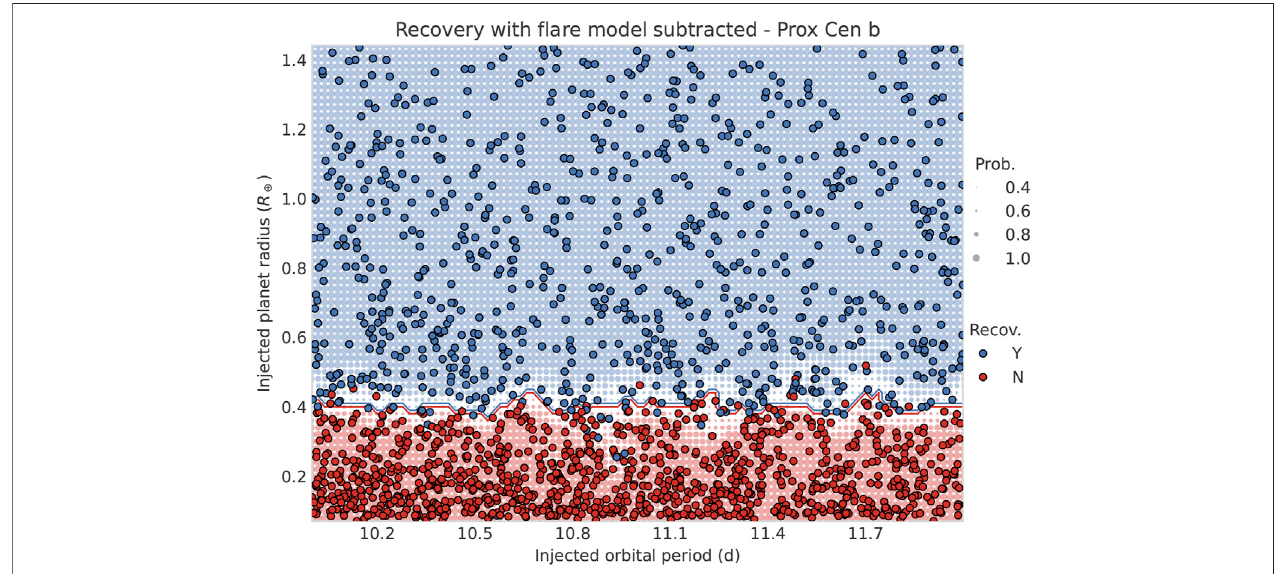
FIGURE3| Bysubtractinga fl aremodelfromthelightcurveofProximaCentauri,weareabletosigni fi cantlyincreasetheprobabilityofrecoveringsmallplanets.We are able to reliably recover planets down to around the radius of Mars across the period range searched, effectively ruling out any transit of Proxima Centauri b.